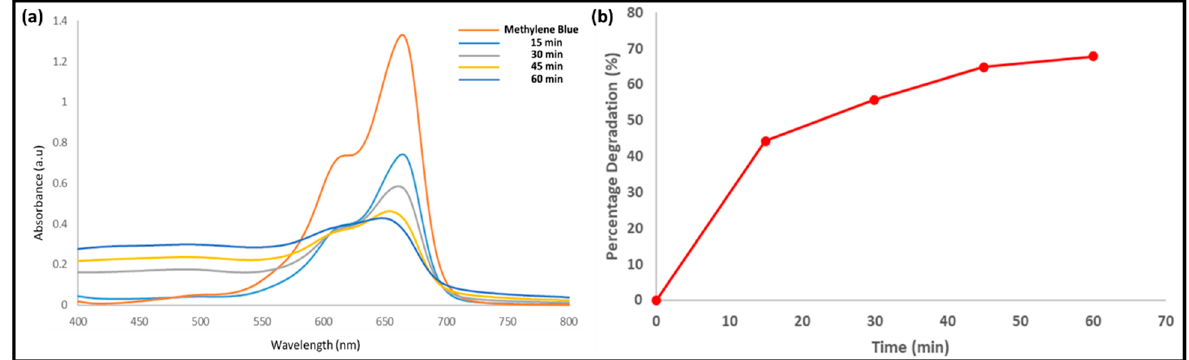
Figure 4. ( a ) Degradation studies using UV-visible spectroscopy. ( b ) Plot of percentage decomposition vs. time.